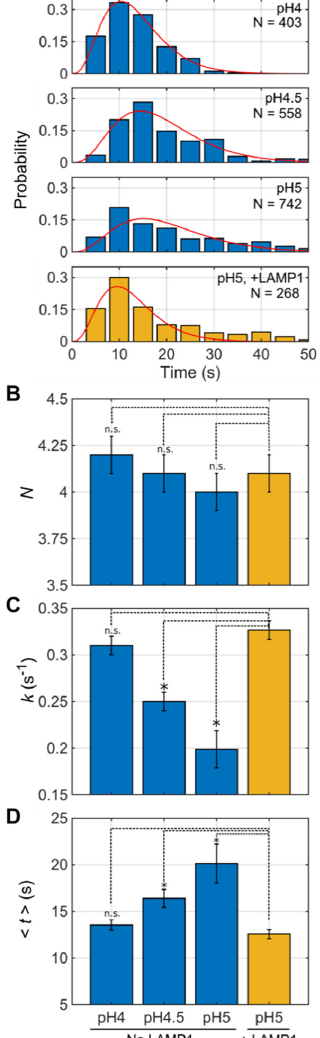
Figure 4. LAMP1 increases the kinetics of GP-mediated lipid mixing. For each lipid mixing event, the interval of time between the 50% decrease in CF fluorescence and DiD dequenching was compiled into a histogram and fit to a gamma distribution by a least-squares algorithm. ( A ) The histogram for each pH considered, in the absence or presence of LAMP1, is shown with the gamma distribution fit overlaid in red. N indicates the number of individual lipid mixing events. ( B ) For each experiment, the number of rate-determining steps leading from the acidification of the flow cell to dequenching was determined through the gamma distribution fitting of each histogram in A. ( C ) The rate constants ( k ) determined from the gamma distribution fitting of each histogram in A. ( D ) The mean time to dequenching, defined as N / k for a gamma distribution. Error bars reflect the 95% confidence intervals determined in the fitting. An asterisk indicates a statistically significant di ff erence as compared to the case of LAMP1 at pH 5 ( p < 0.05.) calculated using a one-way